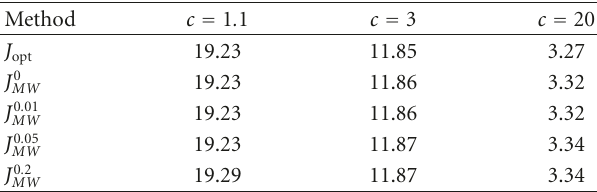
Table 6: Results of the MSE of the LSP for di ff erent parameter choices using Hermite functions as windows and a decreasing number of eigenvalues, N = 32 and F s = 2 . 5.